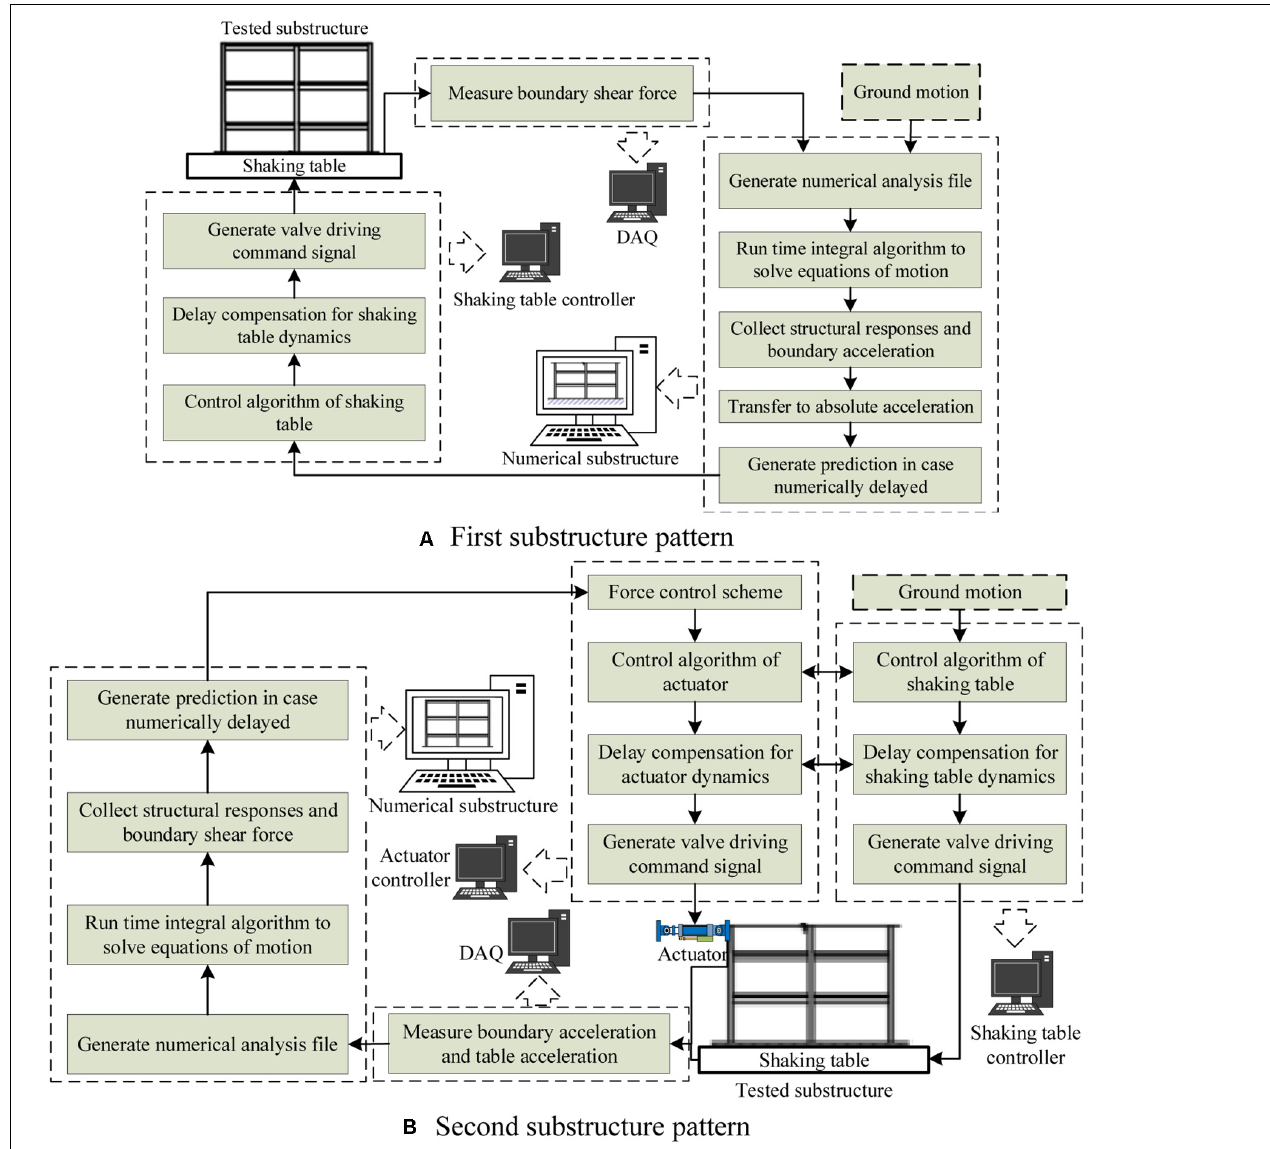
FIGURE 3 | Detailed procedures of STST. (A) First substructure pattern. (B) Second substructure